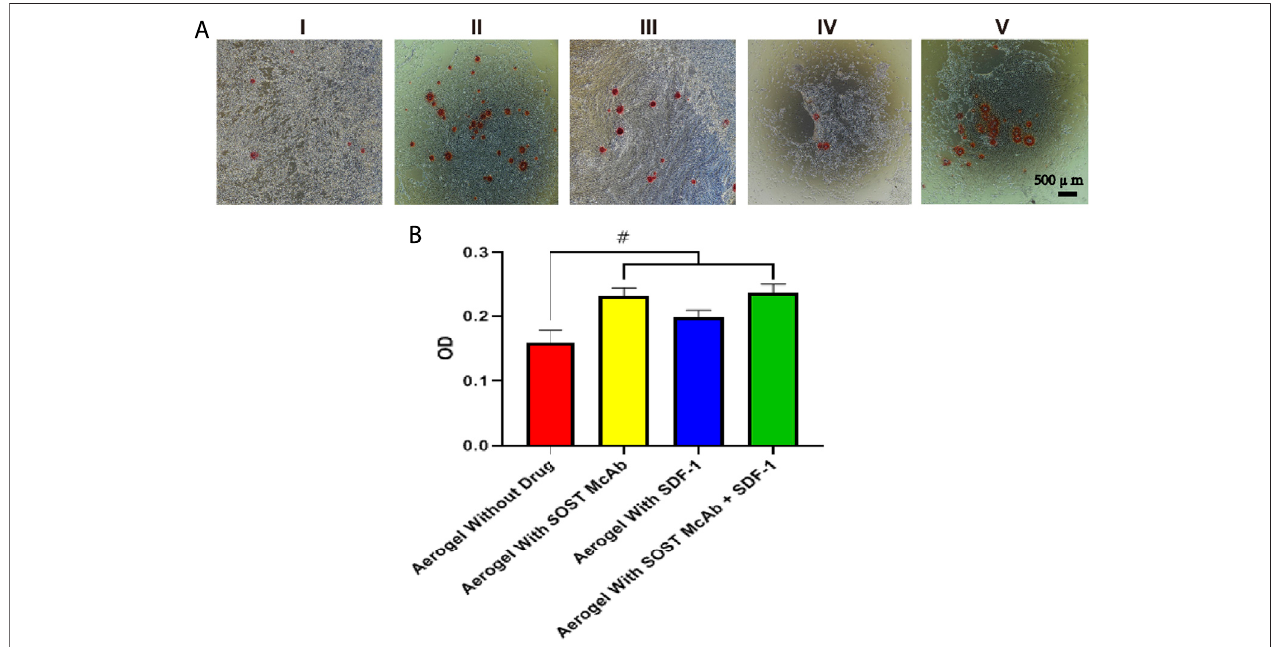
FIGURE 6 | The result of ALP activity and cell mineralization. (A) The results of alizarin red staining (B) alkaline phosphatase detection. The results showed that the aerogelscaffoldwithSOSTMacbhadabetterosteogenicdifferentiationeffectonBMSCs.GroupI,aerogelextractwithoutloadingdrugs;GroupII,theextractofaerogel loaded with SOST McAb, Group III, the extract of aerogel loaded with SDF-1; Group IV, extracted from aerogel loaded with SOST McAb + SDF-1; Group V the control group with simple culture medium. #, p ＜